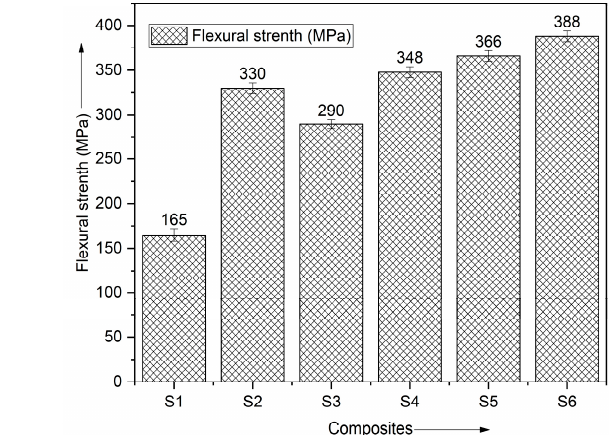
Figure 6. Tensile and flexural strength of hybrid laminates.